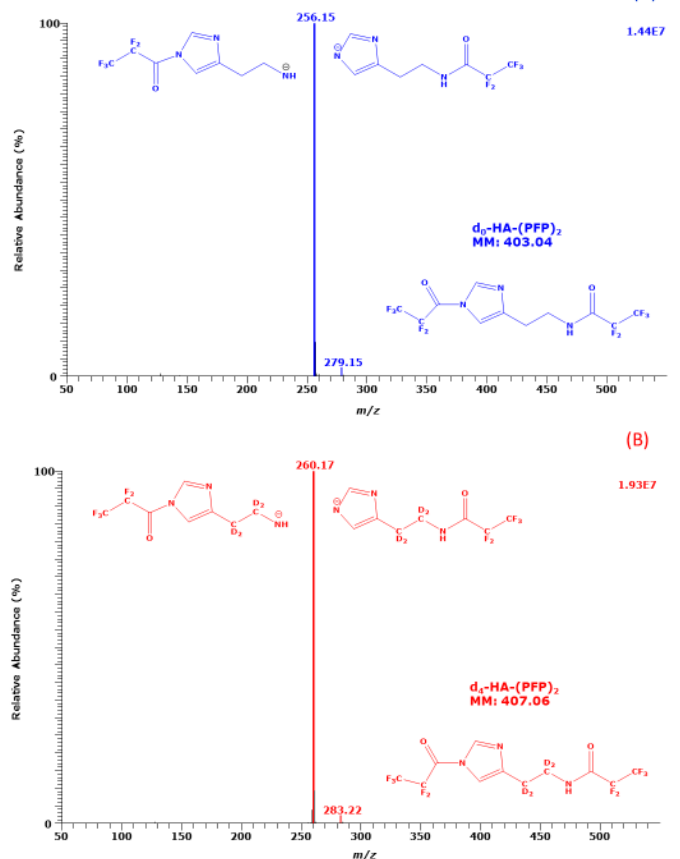
Figure 1. GC-MS negative-ion chemical ionization (NICI) mass spectra of ( A ) unlabelled histamine Figure 1. GC ‐ MS negative ‐ ion chemical ionization (NICI) mass spectra of ( A ) unlabelled histamine (d 0 -HA) and ( B ) deuterium-labelled histamine (d 4 -HA) (each 10 nmol) from their separate (d 0 ‐ HA) and ( B ) deuterium ‐ labelled histamine (d 4 ‐ HA) (each 10 nmol) from their separate derivati ‐